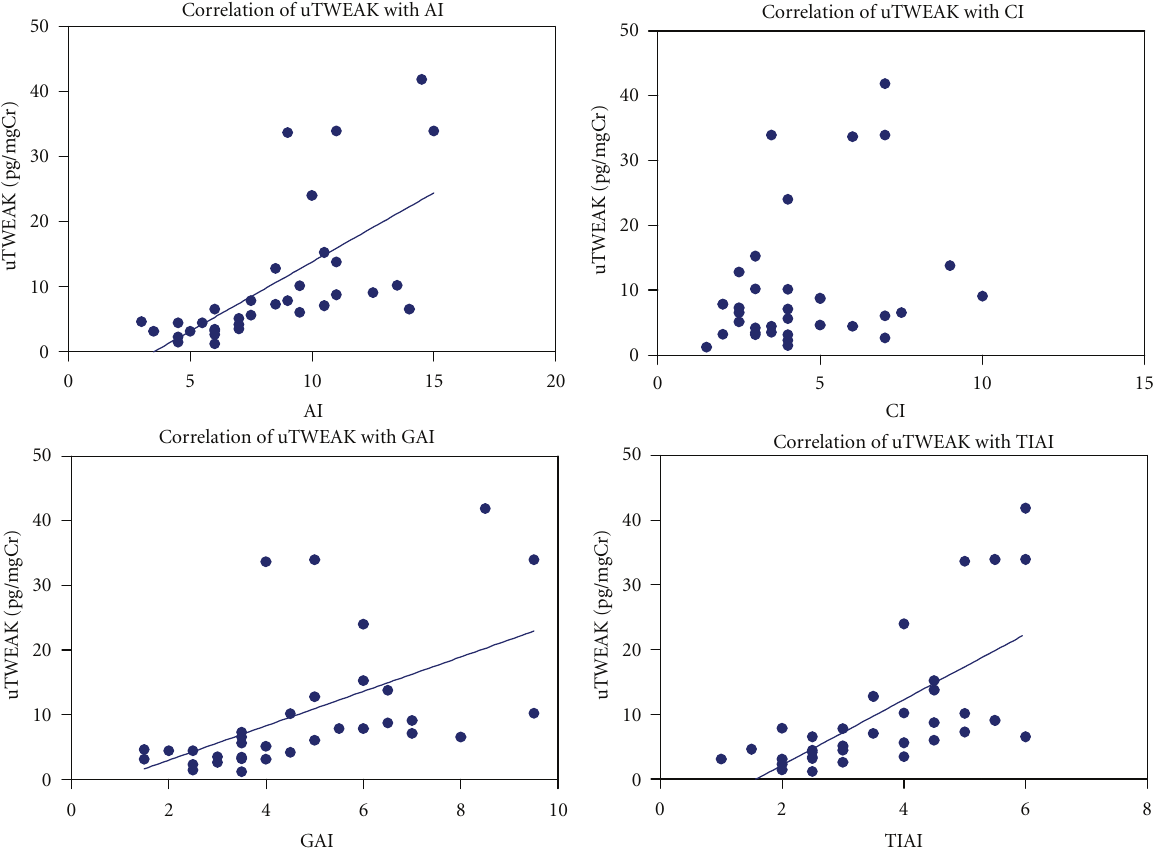
Figure 3: uTWEAK levels correlated with LN renal biopsy index. uTWEAK levels of 34 patients with LN who had routine renal biopsies showed positive correlations with Active Index (AI) ( r = 0 . 825, P < 0 . 01), Glomerular Activity Index (GAI) ( r = 0 . 745, P < 0 . 01), and Tubulointerstitial Activity Index (TIAI) ( r = 0 . 751, P < 0 . 01). uTWEAK levels had no correlation with Chronicity Index ( P > 0 .